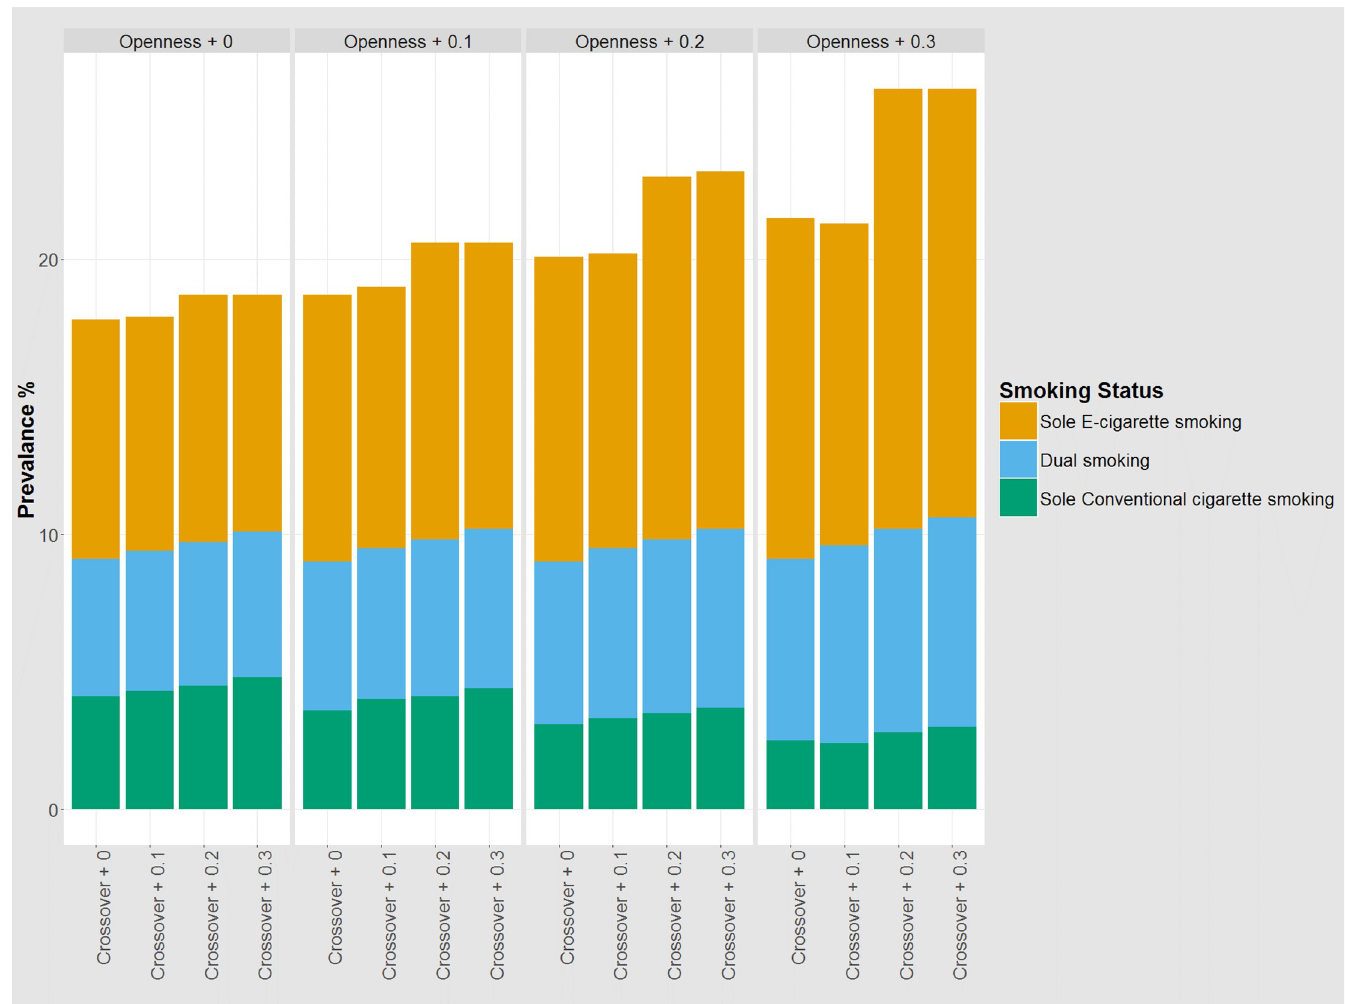
Fig 3. Simulated prevalence rates by type of smoking in counterfactual alternative scenarios as of 2014. ‘Openness + 0’ and ‘Crossover + 0’ represent the baseline scenarios and reflect real-world data drawn from the United States National Youth Tobacco Survey in 2014, as depicted in Fig 1. Simulation results of counterfactual scenarios with incrementally increased levels of young people’s openness to smoking and crossover effects between modes of smoking are presented.